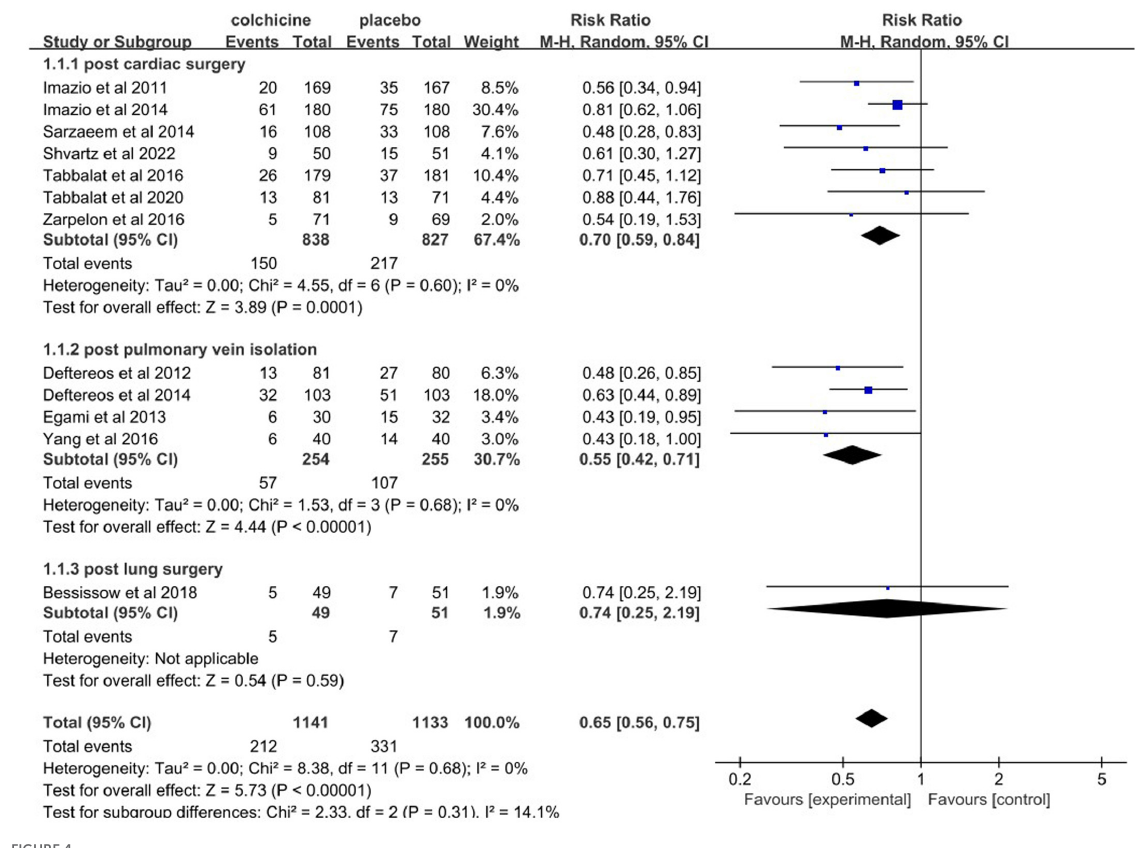
FIGURE4 Forest plot indicates risk ratios of post-operative atrial fibrillation with colchicine.